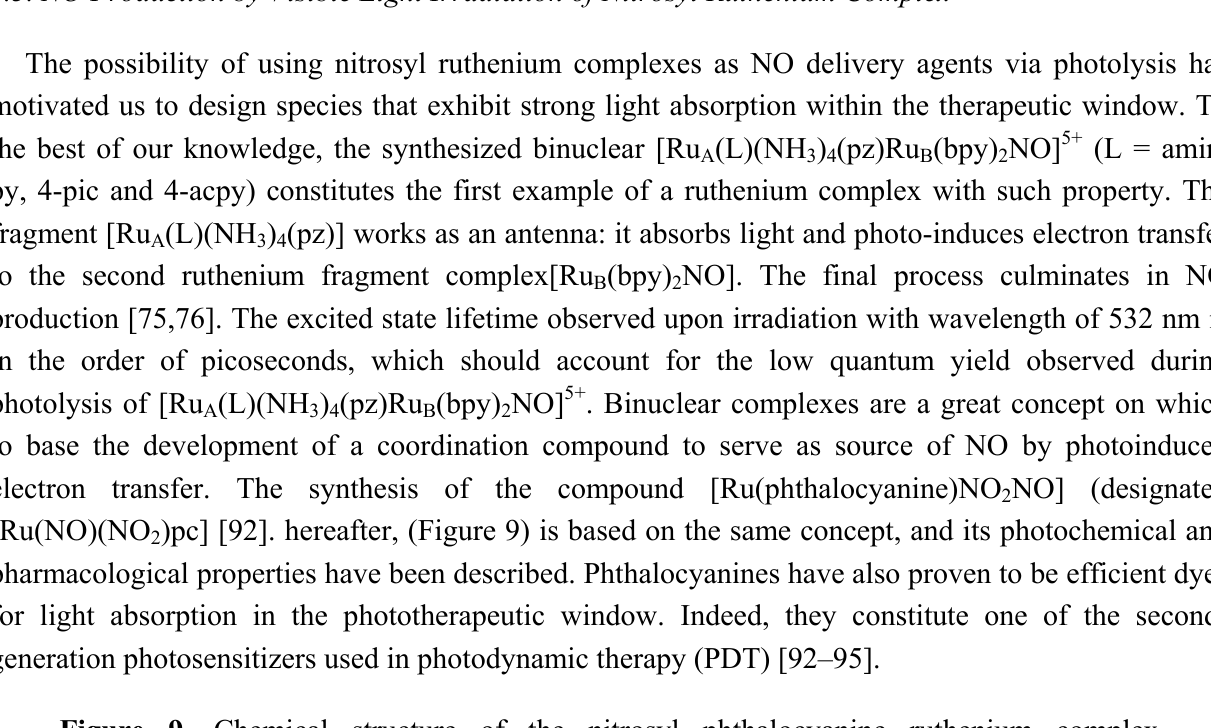
Figure 9. Chemical structure of the nitrosyl phthalocyanine ruthenium complex [Ru(NO)(NO )pc]. The colored circles represent atoms in the chemical structure (cyan: 2 carbon; blue: nitrogen; red: oxygen and gray: